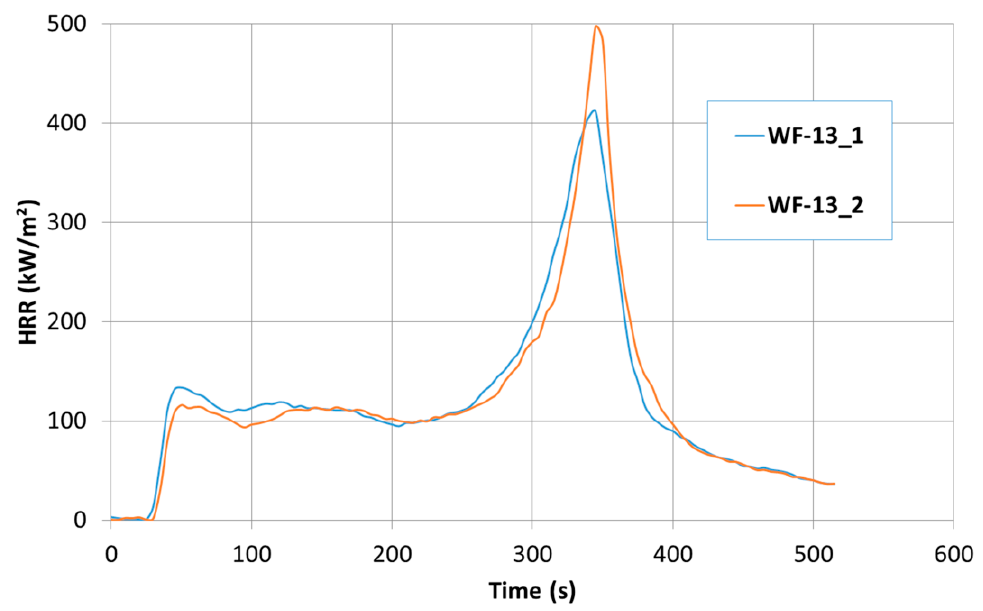
Figure 7. Heat Release Rate (HRR) curves vs. time in the cone calorimeter ISO 5660-1 for coating WF-13 (two tests).